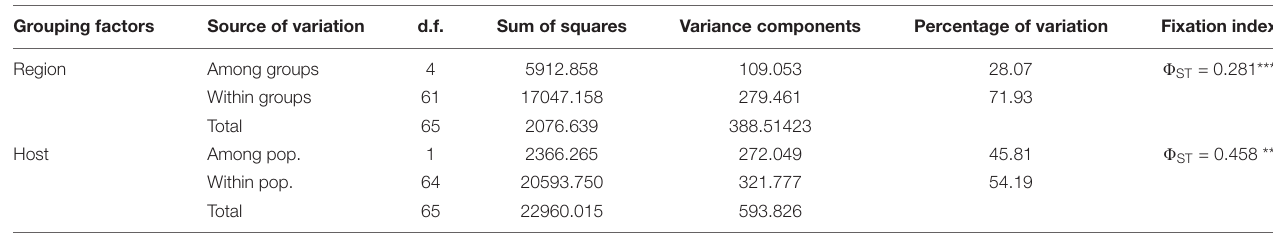
FIGURE 1 | Diagram showing the genomic organization of potato virus A (A) and Sliding-window analysis of population differentiation across geographical and host populations (B) . F ST values were calculated using the R package of PopGenome . The window size is 100 nucleotides, and the step size is 30 nucleotides. TABLE 3 | Analysis of molecular variance for the effects of geography and host